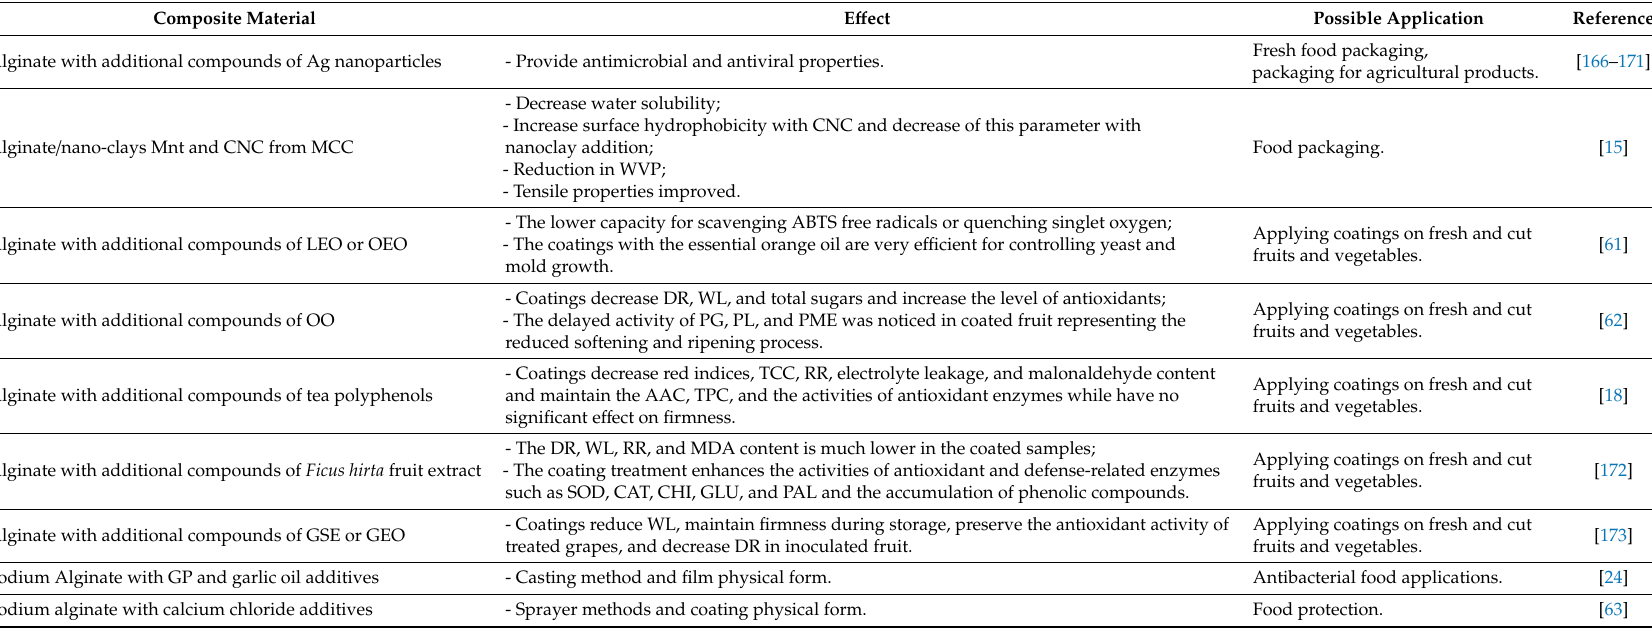
Table 2. Alginate properties used for di ff erent